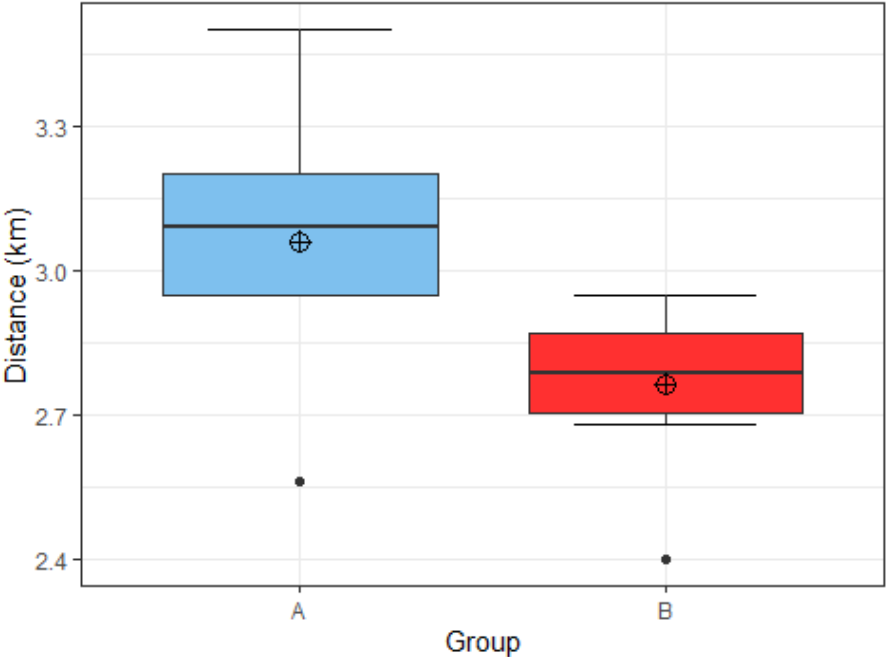
Figure 19. Distribution of distance covered in the Cooper test by group A ( n = 5) and group B ( n = 10). Group A: appropriate intake of protein and carbohydrate. Group B: inappropriate intake of protein or carbohydrate.